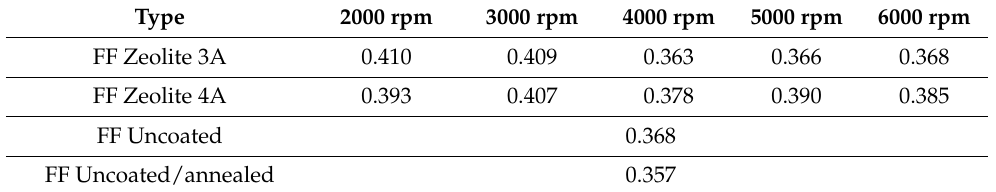
Table 2. Fill factor vs. deposition parameters for zeolite-coated and control solar cells.